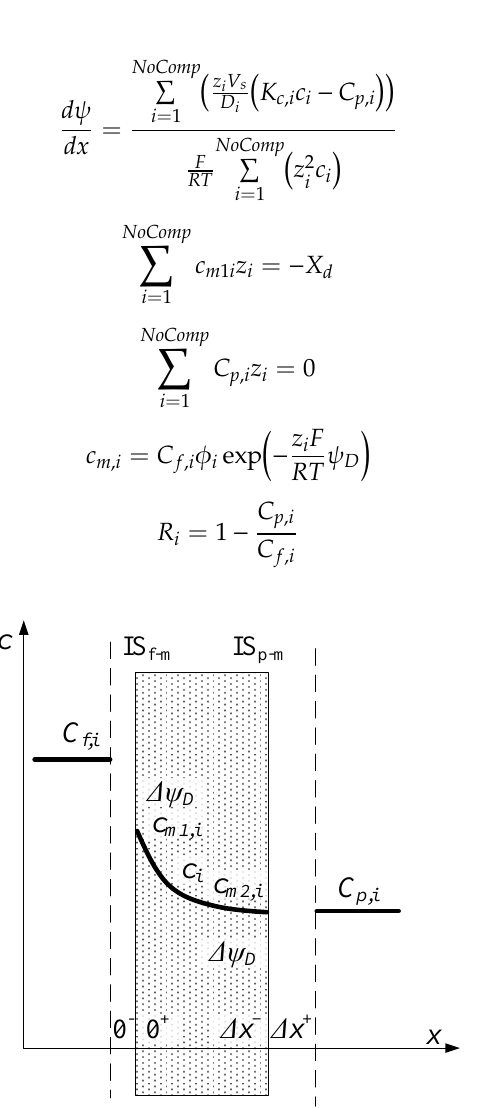
Figure 2. Concentration profiles of ions in the membrane active layer and external solutions, considering the Donnan potentials, where C f,i and C p,i are the concentrations of individual ion in the feed and permeate solution, respectively; ∆ x is the membrane active layer thickness; c m 1 ,i and c m 2 ,i are the concentrations of the individual ion at both the feed and permeate boundaries, respectively; c i is the concentration of individual ion along the pores. IS f-m and IS p-m represent the interfacial surfaces of feed–membrane and permeate–membrane, respectively.